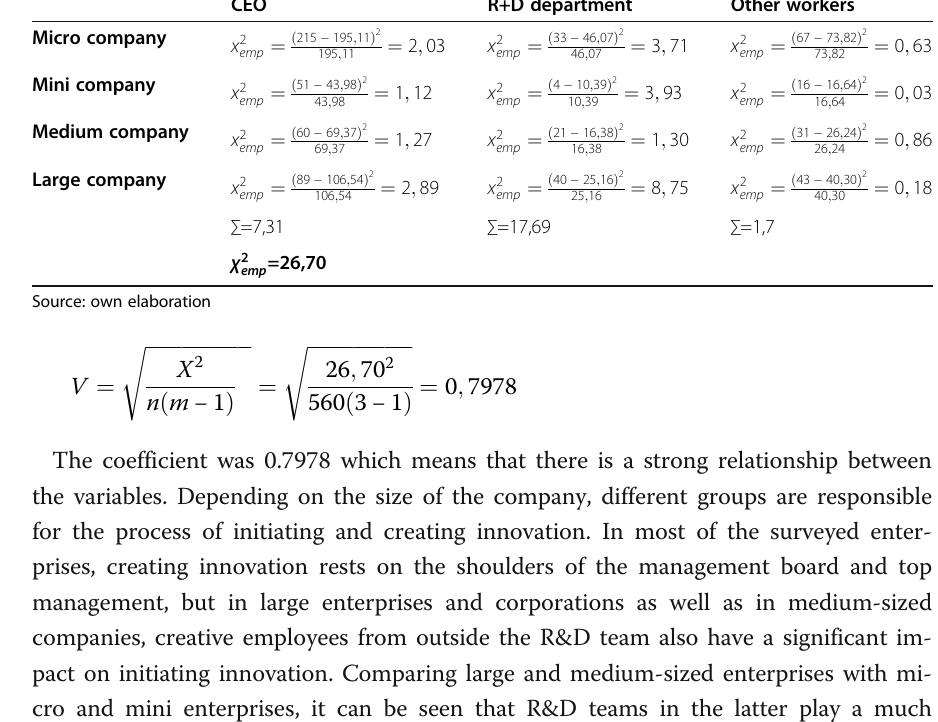
Table 4 Chi-squared empirical χ 2 emp CEO R+D department Other workers Micro company